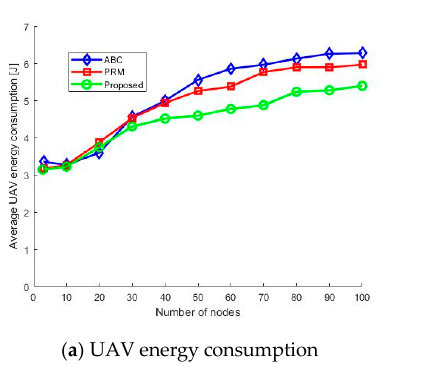
Figure 8. Energy consumption.